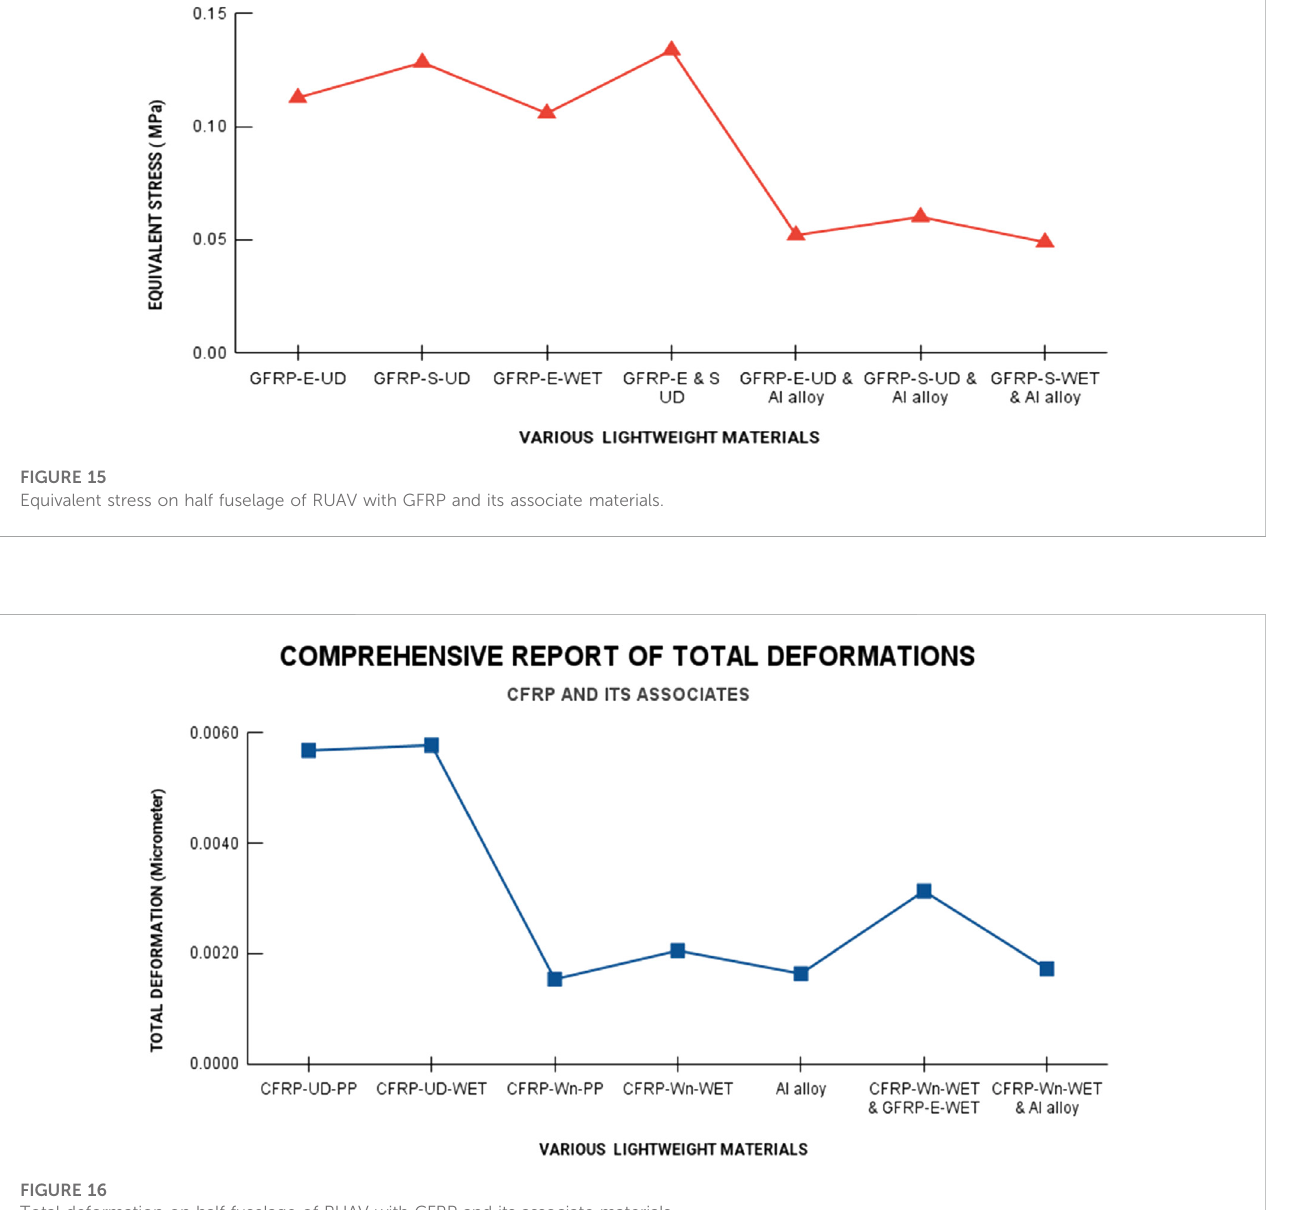
Total deformation on half fuselage of RUAV with CFRP and its associate